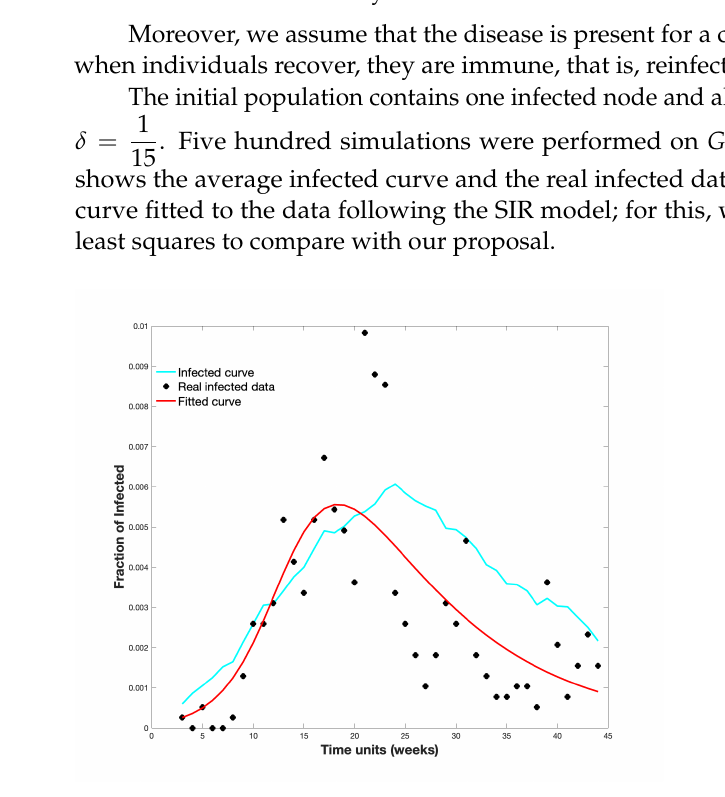
Figure 7. Real infected data (black), fitted curve (red), and infected curve obtained in the spread on G E